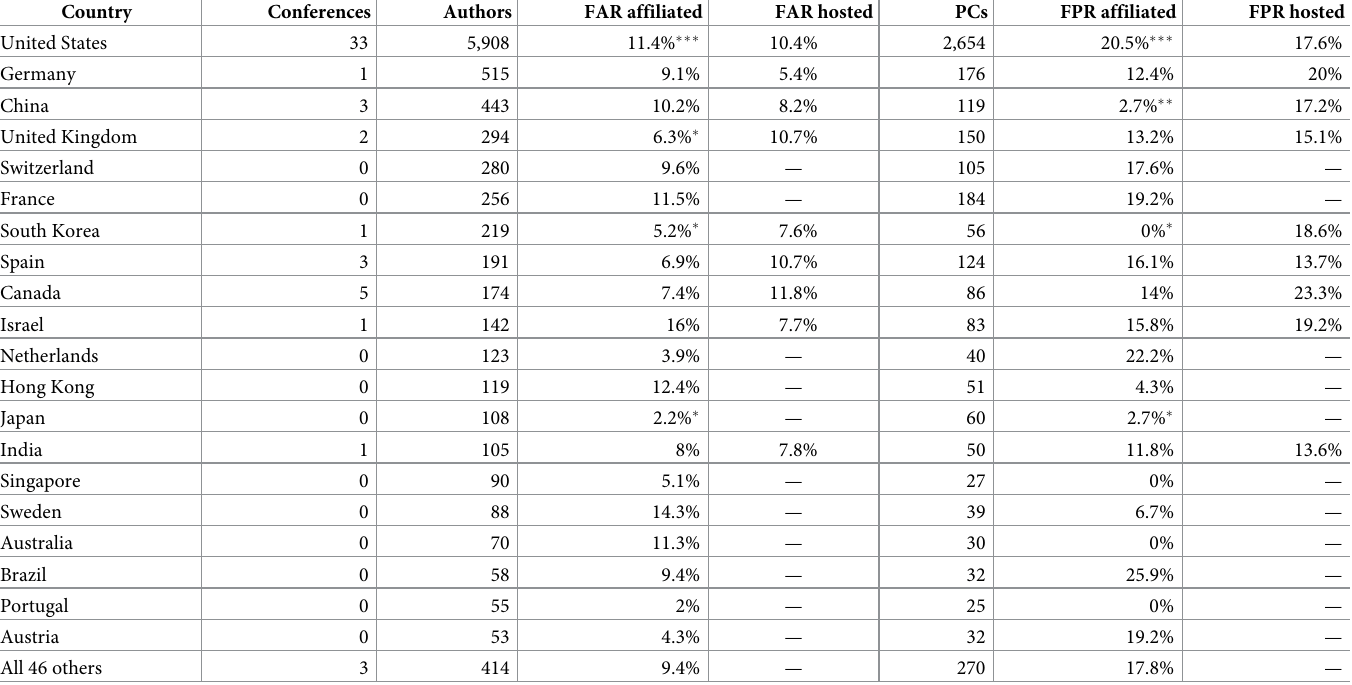
Table 6. Representation of women in the top 20 countries by author count. Shown for each country are: the number of conferences it hosted; total authors affiliated with the country; ratio of these authors that are women (FAR affiliated); ratio of female authors in local conferences (FAR hosted); total number of affiliated PC members, ratio of these that are women (FPR affiliated), and FPR in all locally hosted conferences. All counts include only persons whose email is unambigously affiliated with that country (with repeats). Women’s ratios are compared to all other countries with a χ 2 test ( � p < 0.05; �� p < 0.01; ��� p < 0.001). Country Conferences